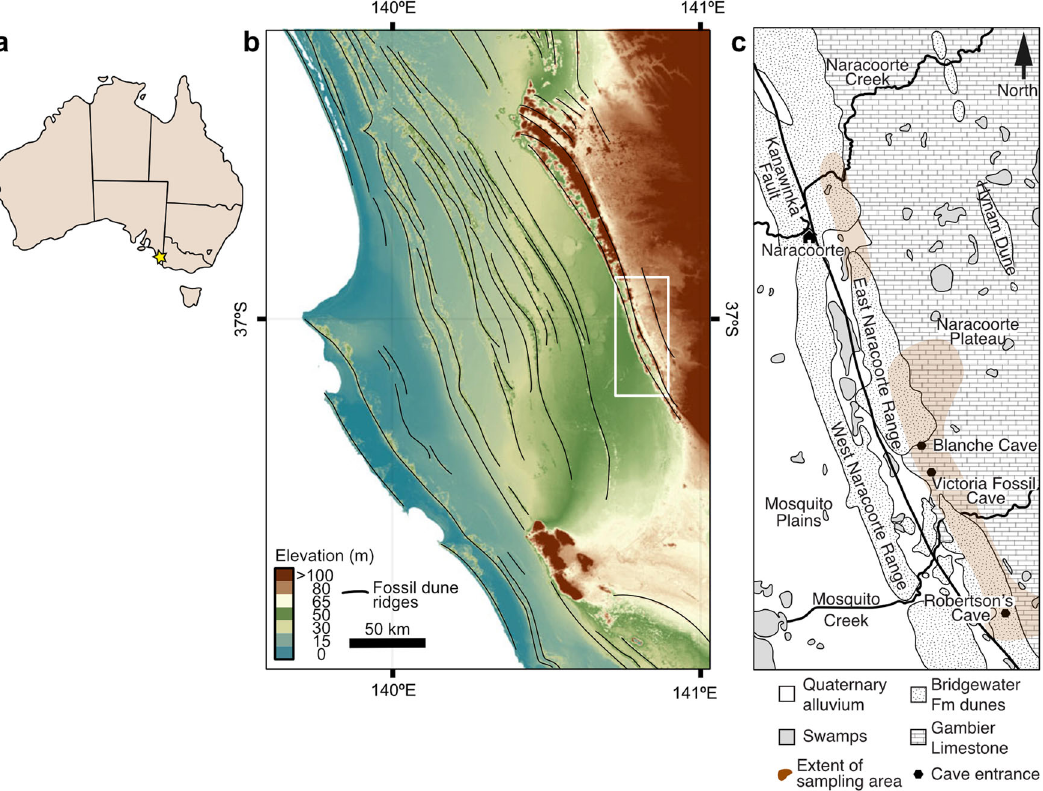
Fig. 1 Overview and geological map of the Naracoorte Cave Complex (NCC) and analysis of the speleothem ages versus elevation. a Location map showing the study site (yellow star). b Shuttle Radar Topography Mission (SRTM) image of coastal southeast South Australia and the NCC (indicated by the white rectangle) with Pleistocene and Holocene fossil dune ridges highlighted by thin black lines, modi fi ed after Murray-Wallace 18 . c Geological map of the study area modi fi ed after White and Webb 20 . The NCC is concentrated along an uplifted portion of the Gambier Limestone, overlain by the Pleistocene East Naracoorte Range. The main tourist caves are depicted by black dots; the rest of the sampling area is indicated simply by a brown shade, as some caves are on private